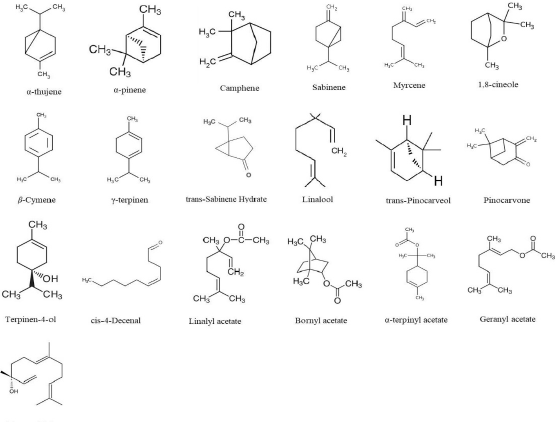
Figure 1. The chemical structure of compounds of Elettaria cardamomum essential oil obtained from the GC/MS. 2.2. Acaricidal Activity against H. anatolicum Females Figure 1 shows the in vitro effects of ECEO against H. anatolicum adult females by assessment of mortality rate, mean number and weight of eggs, hatchability percentage, and product efficiency in immersion test. Through AIT, the obtained findings revealed that ECEO significantly ( p < 0.001) increased the mortality rate as a dose-dependent re- sponse; concentrations of 10, 20, and 40 µL/mL caused 100% mortality in engorged fe- males (Figure 2). The calculated LC 50 and LC 90 values for ECEO were 3.79 and 6.81 µL/mL, respectively. The results also showed that after treatment of H. anatolicum adult females with various concentrations of ECEO, the number of eggs (Figure 2), egg weight (Figure 2), and hatchability (Figure 2) declined significantly in a dose-dependent response com- pared to the control group.